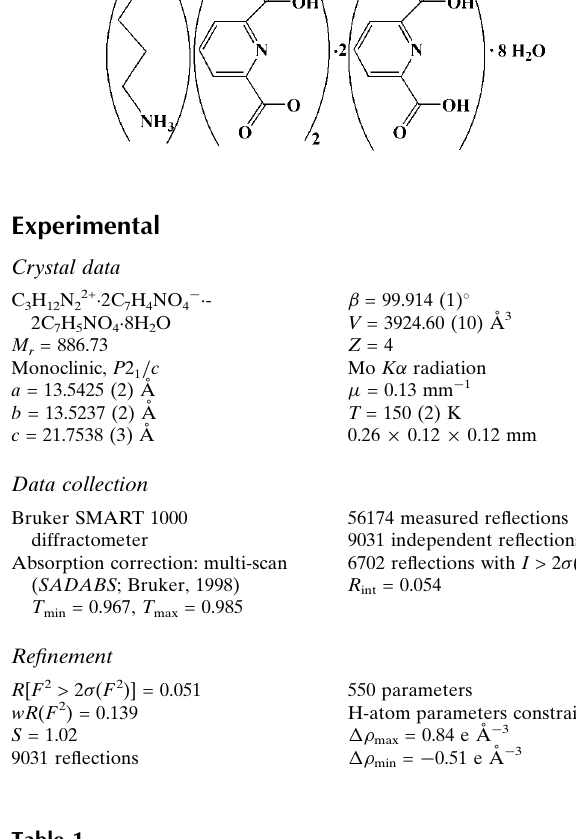
Hydrogen-bond geometry (A˚ , (cid:3) ). D —H (cid:1)(cid:1)(cid:1)